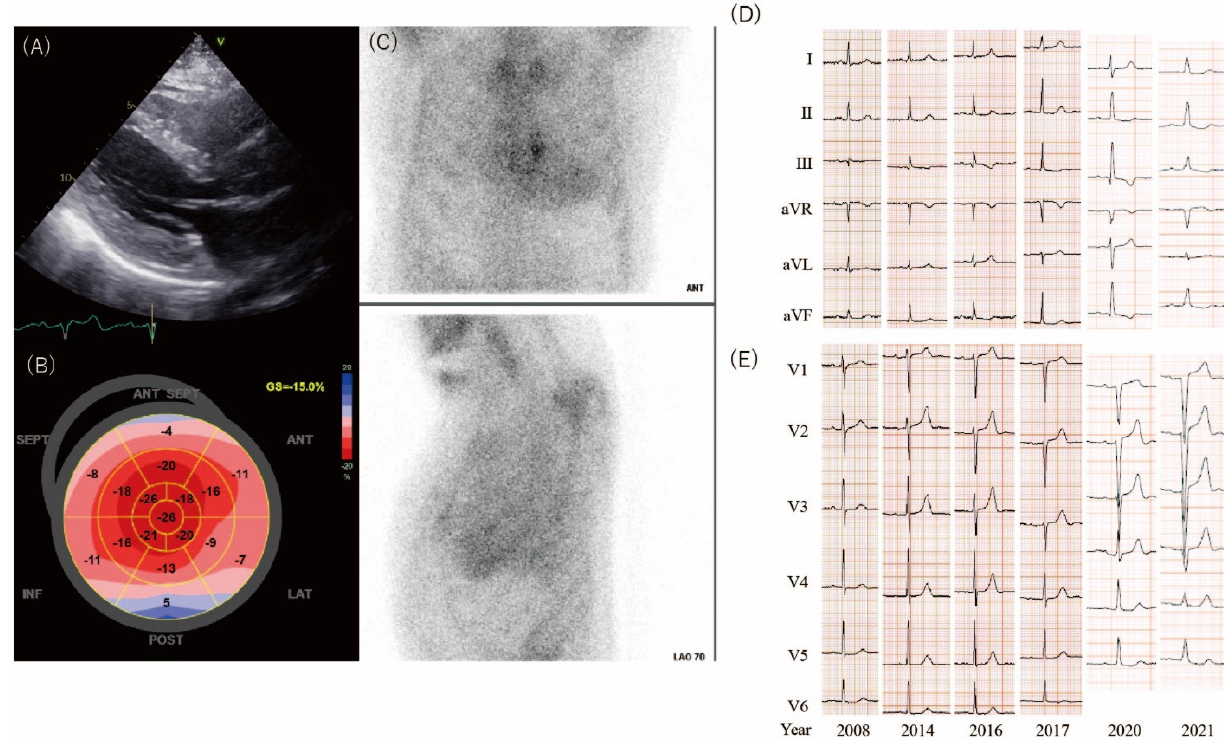
Figure 1. ( A ) Echocardiography in 2020 showing left ventricular hypertrophy (interventricular sep- tum, 11 mm; posterior wall, 11 mm). ( B ) Relative apical sparing by longitudinal speckle tracking strain imaging. ( C ) Technetium hydroxymethylene diphosphonate showing diffuse radiotracer uptake in the myocardium. ( D ) Electrocardiogram change over time in the limb leads. ( E ) Electrocardiogram change over time in the precordial leads.